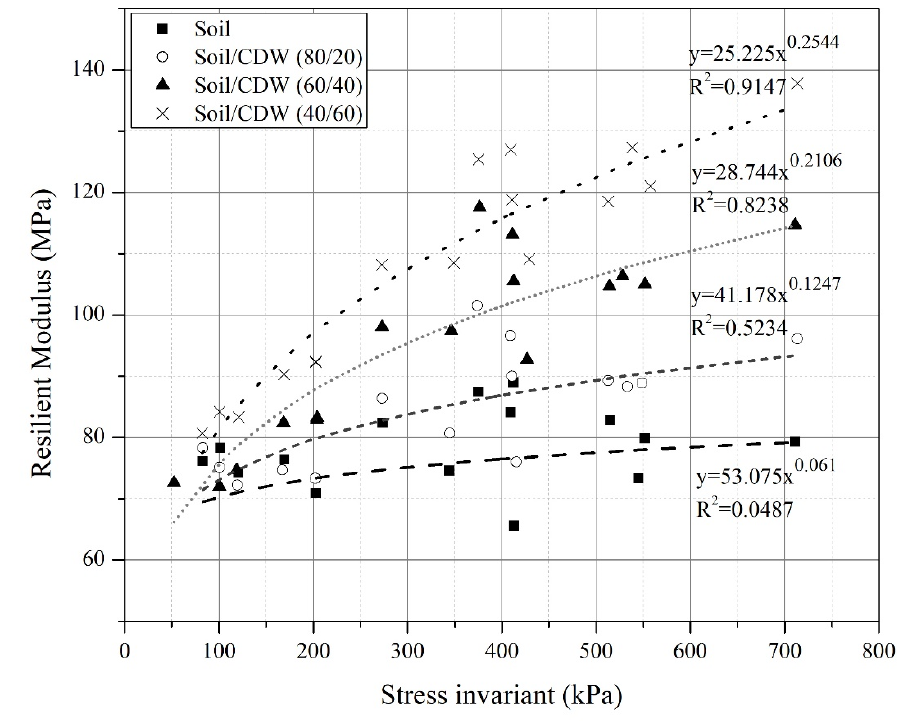
Figure 12. Resilient modulus of residual soil and brick CDW.